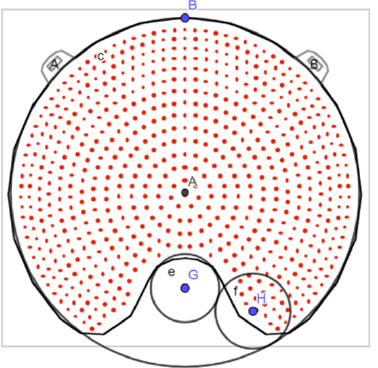
Figure 10. Plaque Simulator diagram of the COC plaque with the superposition of the circles that parameterize the cutout with the parameter values corresponding to the modified geometry.